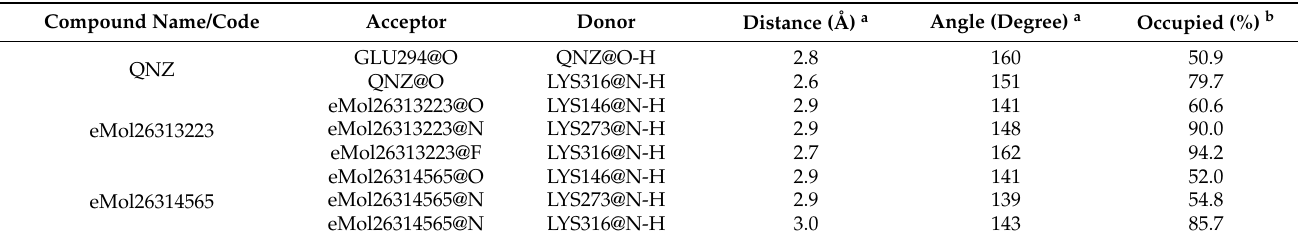
Table 4. Hydrogen bonds demonstrated between the identified inhibitors and the key amino acid residues inside the allosteric site of the mutated PBP2a in acidic medium.